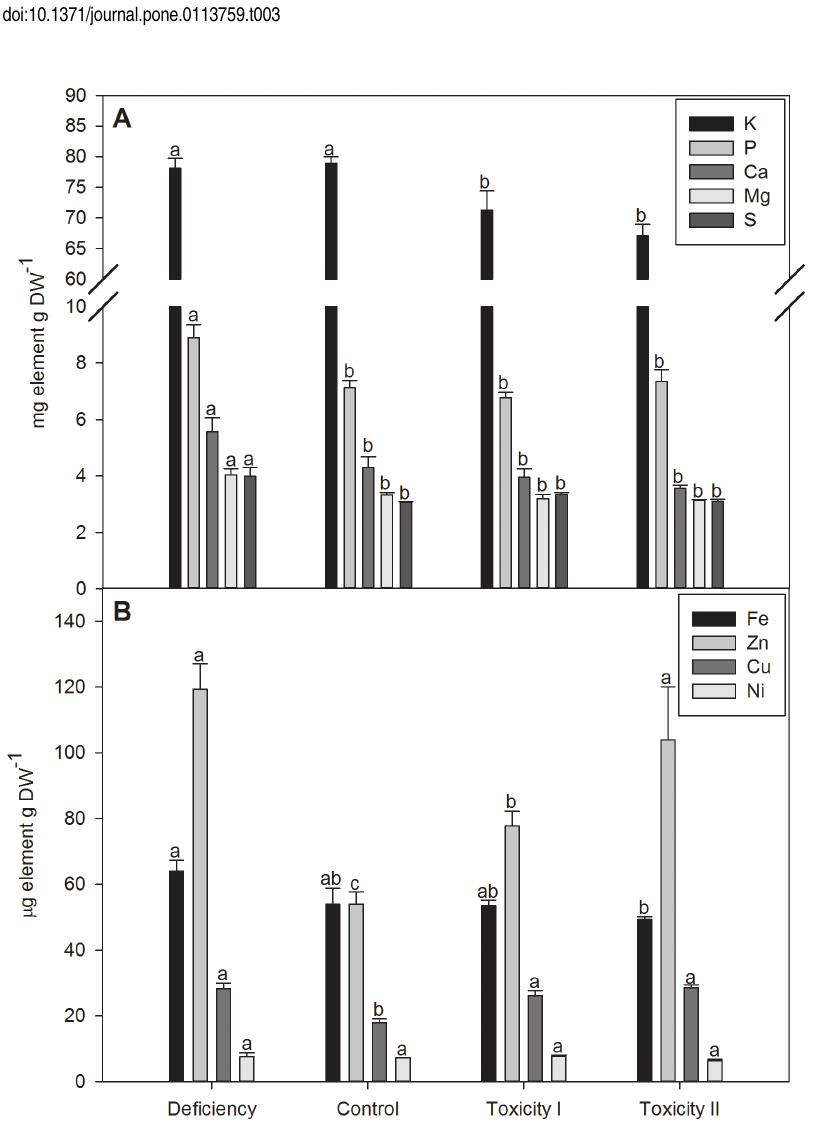
Values with the same superscript letter were not significantly different between treatments (P . 0.05).